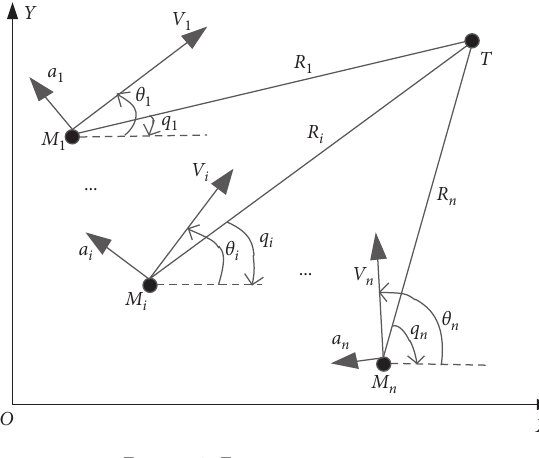
Figure 1: Engagement